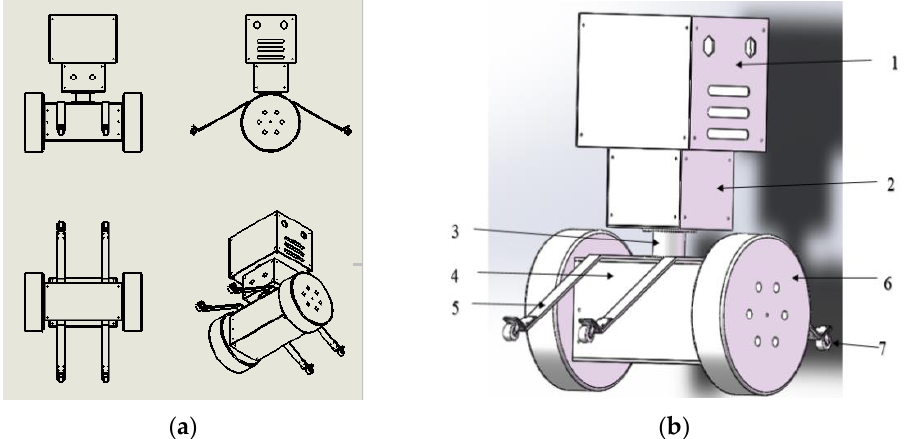
Figure 1. ( a ) Two-dimensional plan of inspection robot. ( b ) Three-dimensional structure drawing of inspection robot.